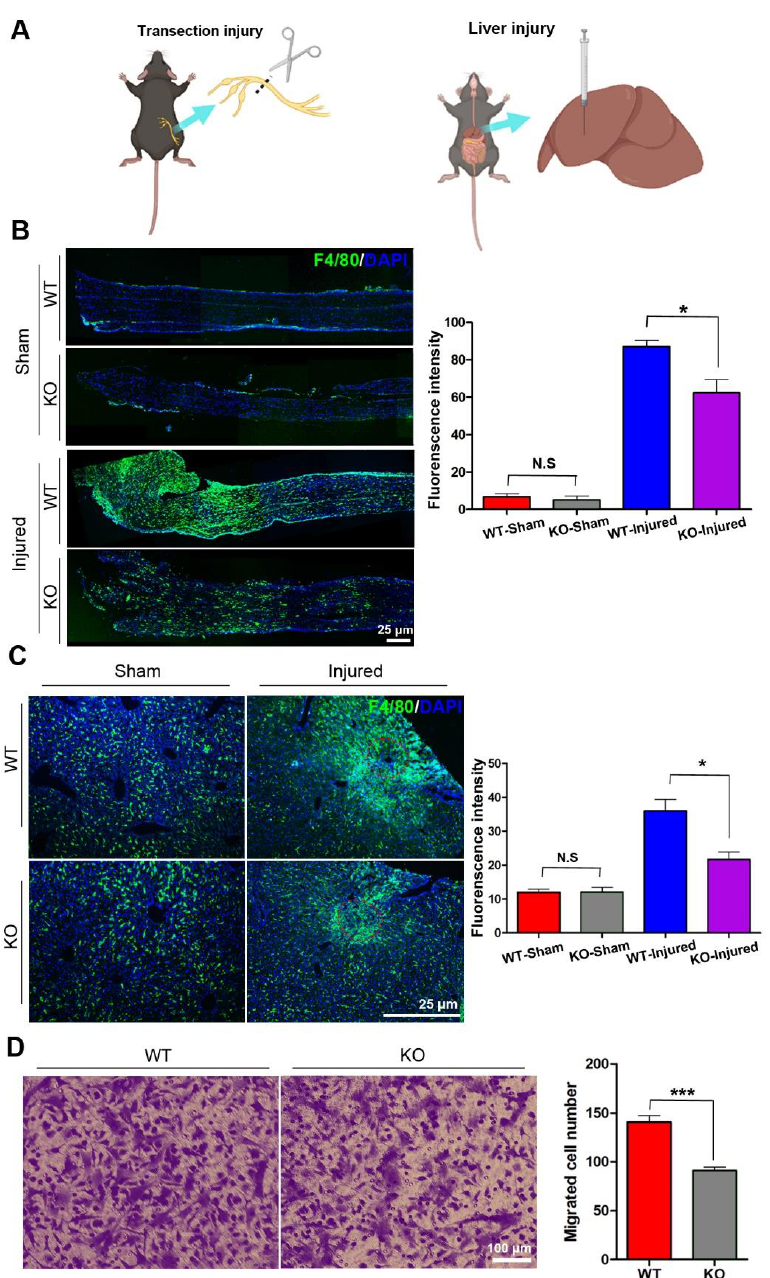
Figure 1. miR-301a knockout inhibits the migration of macrophages in vivo and in vitro. ( A ) Sciatic nerve transection injury model and liver needle stick injury model. ( B ) Immunohistochemistry and quantitative analysis in the longitudinal sections of transected sciatic nerve’s distal trunk at 5 dpi, which shows the recruited macrophages in the KO group are less than the WT group. Scale bar: 25 µ m. ( C ) Immunohistochemistry and quantitative analysis in the needle stick injured liver showing that the migrated macrophages to the injury site in the KO group are less than the WT group. Scale bar: 25 µ m. ( D ) Transwell assay and quantitative analysis showing the number of migrated macrophages in the KO group is significantly less than the WT group in vitro. Data are expressed as the mean ± SEM ( n = 6 for each group, N.S: p ≥ 0.05, * p < 0.05, *** p <